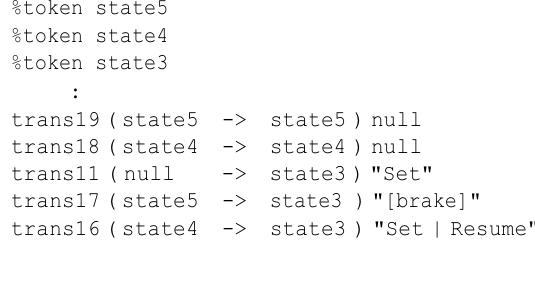
Fig. 4. Intermediate listing for code in Fig.